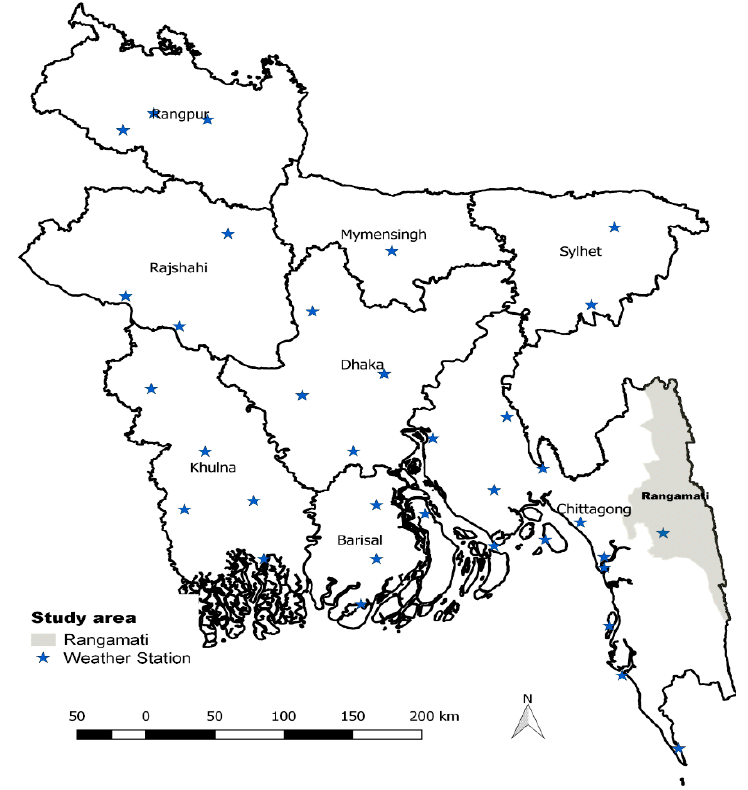
Figure 1. Bangladesh map showing the study area (Rangamati subdistrict shaded in grey) and available weather stations.